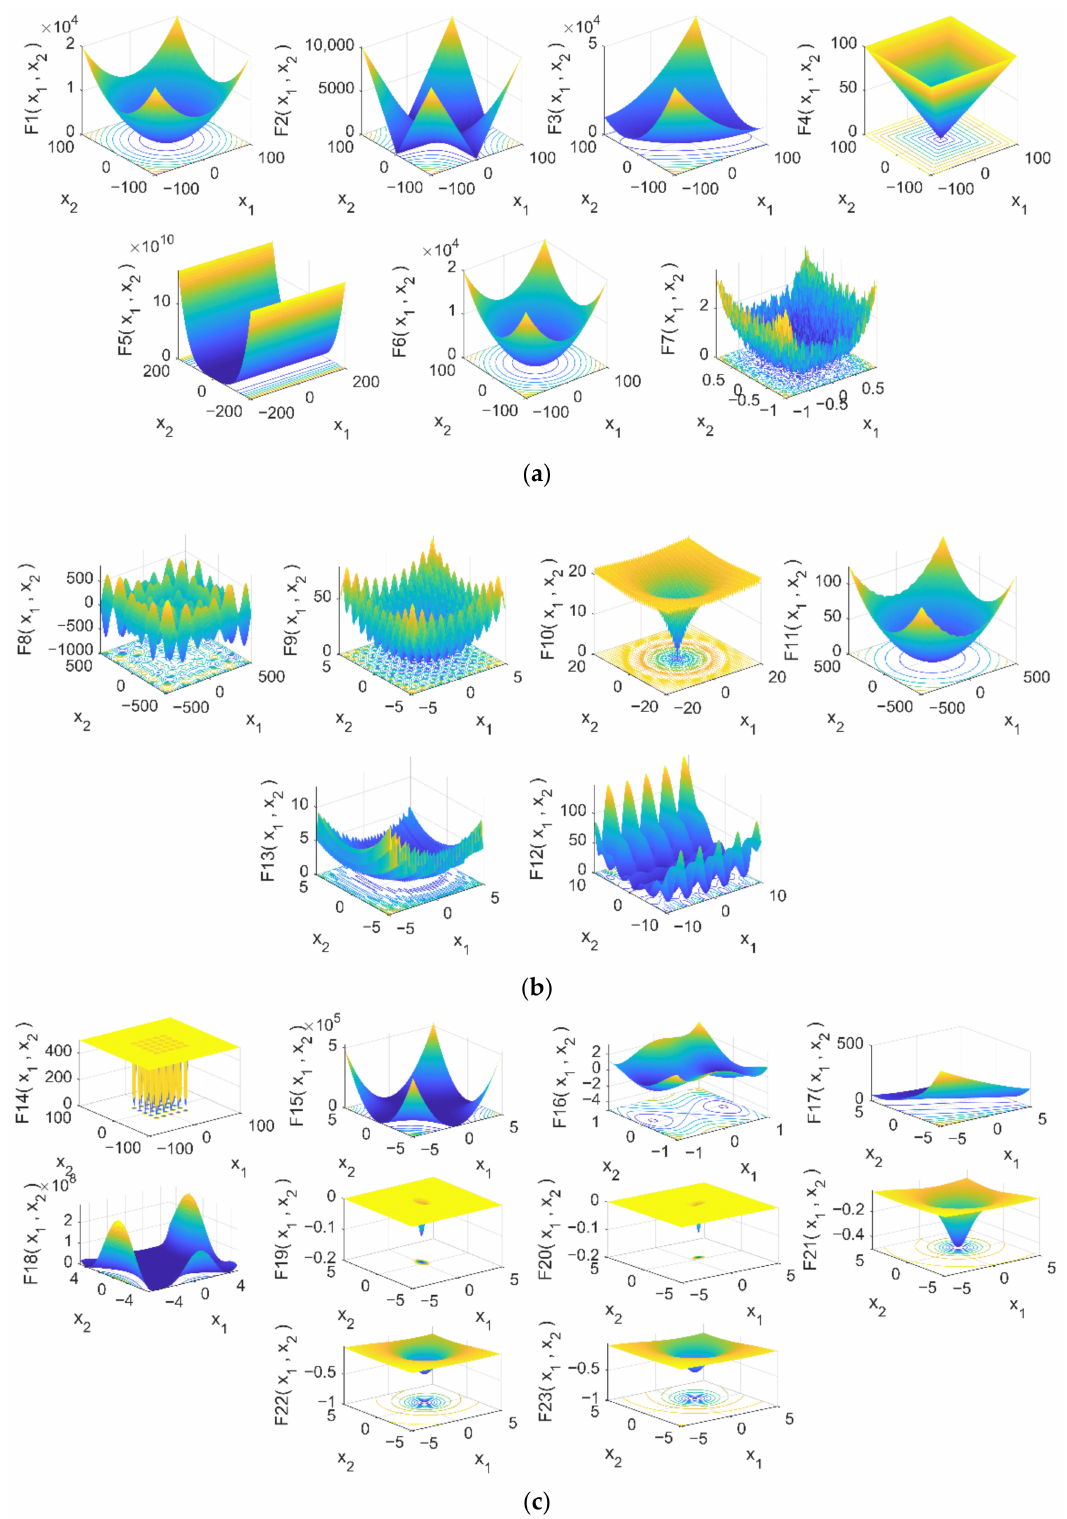
Figure 5. Three-dimensional view of the search space for 23 benchmark functions. ( a ) Unimodal benchmark function, benchmark functions. ( b ) Multimodal benchmark function, benchmark func- tions. ( c ) Fix-dimension multimodal benchmark function, benchmark